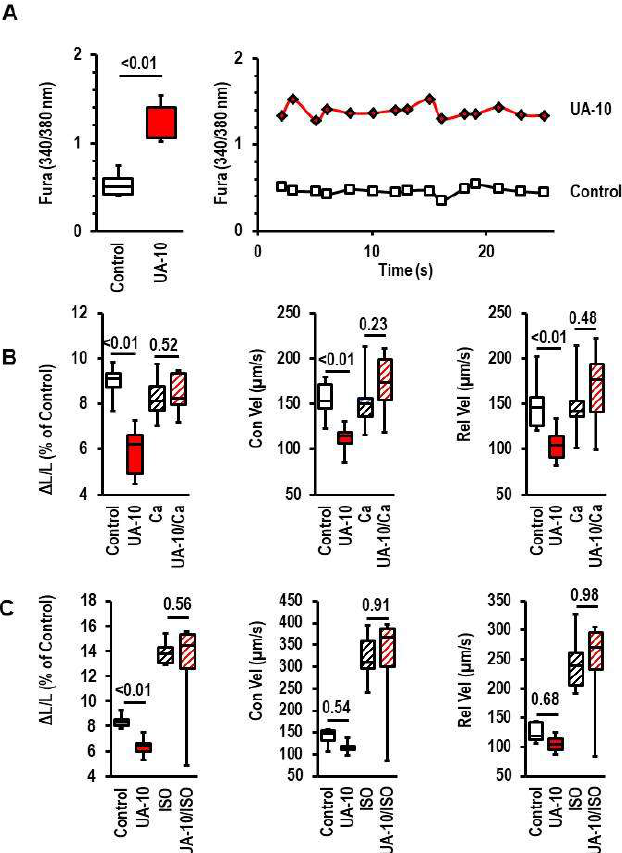
Figure 6. Effect of uric acid (UA) on calcium transients ( A ) and of calcium mobilization on UA- induced effects on cell shortening. In ( B ), extracellular calcium concentration is increased from 1.25 mmol/L (control) to 1.75 mmol/L (Ca). In ( C ), the β -adrenoceptor agonist isoprenaline (ISO, 10 nmol/L) was added. Data are expressed as bars and whiskers with median, 25% quartile, 75% quar- tile indicated by bars, and complete range by whiskers. Statistical analysis is based on Student t - tests and exact p -values are indicated. Data show the effects on cell shortening (( A ) ; ΔL/L), contrac- tion velocity (( B ); Con Vel), and relaxation velocity (( C ); Rel-Vel). Data are means from n = 5 (calcium transients) or n = 10 ( B , C ) preparations (rats), with 4 cell culture dish per preparation and 9 cells evaluated per cell culture dish. Statistical analysis is based on preparations. In ( A ), a representative single-cell recording for two cells is also given for 15 consecutive calcium transients.